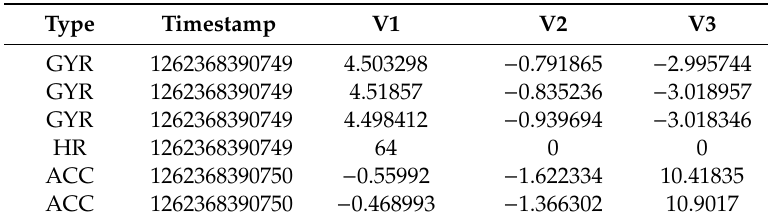
Table 1. Excerpt from a session